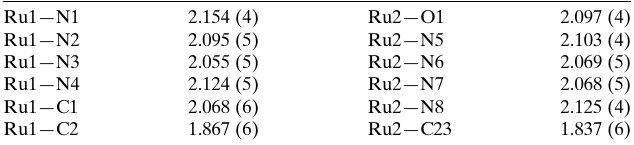
Table 1 Selected bond lengths (A˚ ).